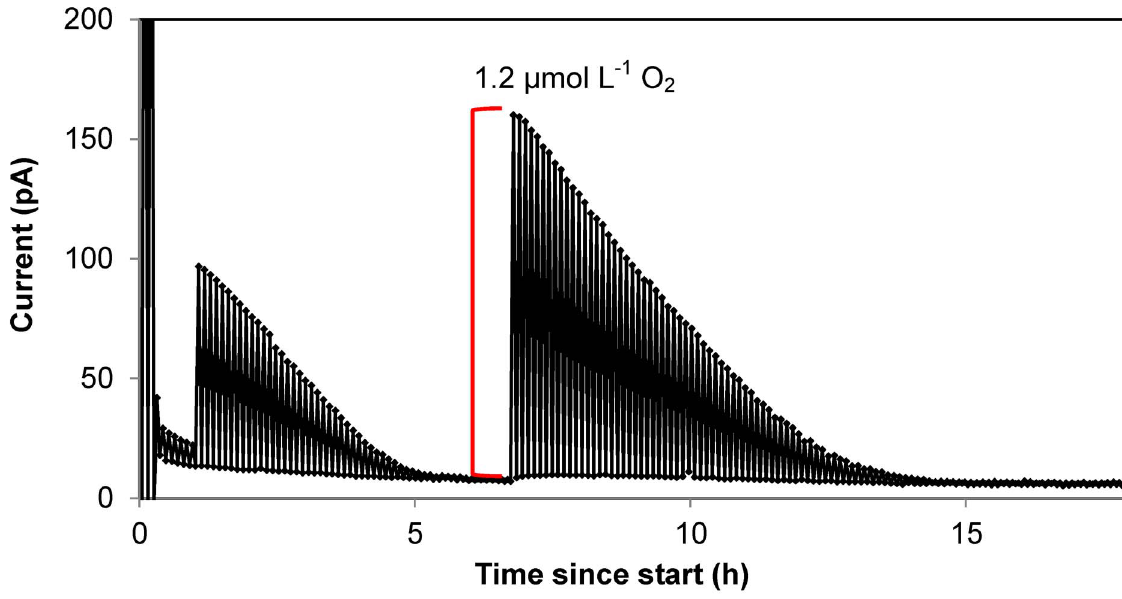
Figure 3. Time course of oxygen depletion in a STOX sensor incubation with coastal seawater. Example of STOX sensor data from incubation of water from Station 2 (Marselisborg Marina, September 2011). Only minimum and maximum readings during each cycle are plotted and connected with lines. The difference between maximum and minimum readings is used as a measure of the O 2 concentration. The initial amplitude of the signal (11 pA) corresponds to an O 2 concentration in the bottle of 200 nmol L 2 1 . Injections of air saturated water were made at 1 h (2 mL,